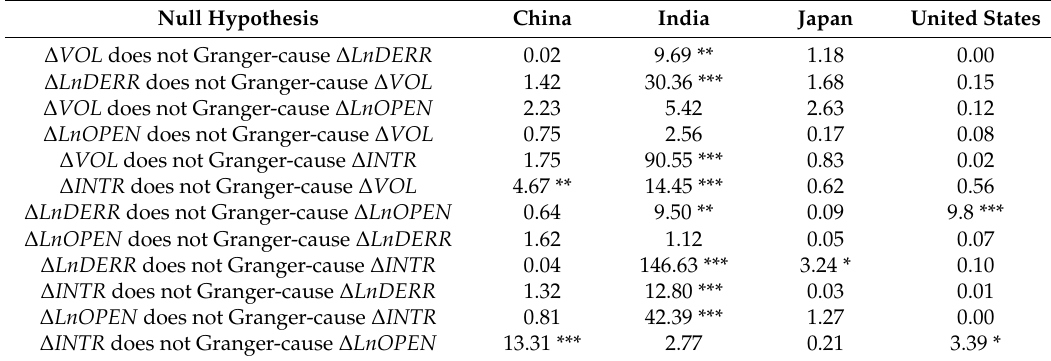
Table 8. Causality tests (the model include the volatility of GDP growth). Null Hypothesis China